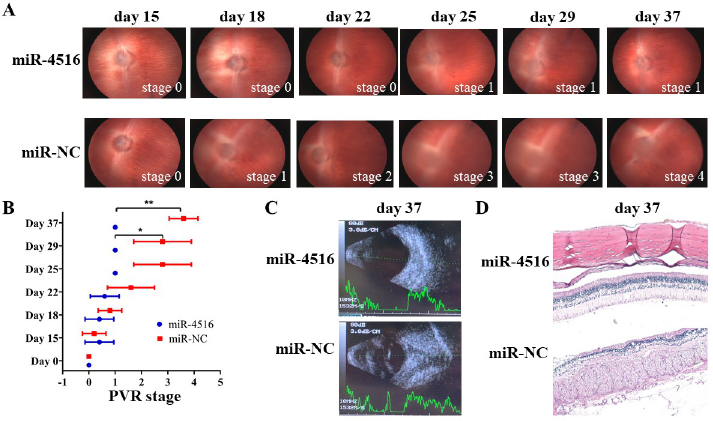
Fig 7. Overexpression of miR-4516 inhibited the PVR progression in vivo. (A) 0.1 mL of TGF- β 2 (10 ng/mL) and 0.1 mL of balanced salt solution containing approximately 1 × 10 6 miR-4516 and ARPE-19 cells transfected with miR- negative control (NC) were injected into the right eyes. A total of four doses was administered to each eye on days 1, 8, 15, and 22. PVR progression was determined according to the Fastenberg classification (stages 1–5) at day 37 post- injection. (B) Results from the independent samples U test of differences in PVR stage between the control group and the miR-4516-treated group. (C) Ultrasonic examination of the control eye and the miR-4516-treated eye at day 37 post-injection. (D) Hematoxylin and eosin staining revealed the presence of dense fibrovascular membrane tissue and considerably higher infiltration of inflammatory cells on the retinal surface of eyes treated with miR-NC compared with that of eyes treated with miR-4516. � p < 0.05; �� p <